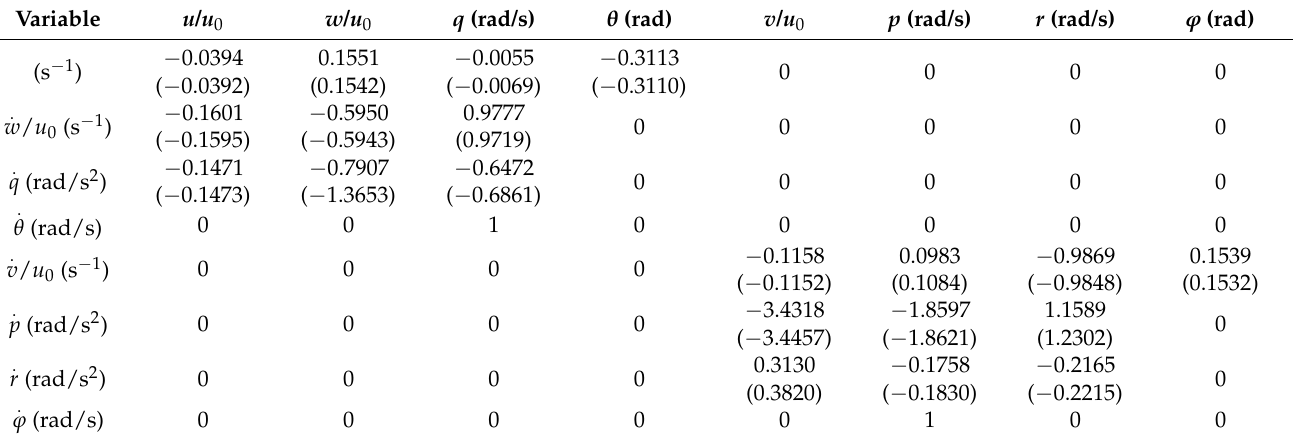
Table 19. CFD–RANS (extrapolated) 8 × 8 stability matrix for flight condition 13 in Tables 4 and 22 (reference takeoff